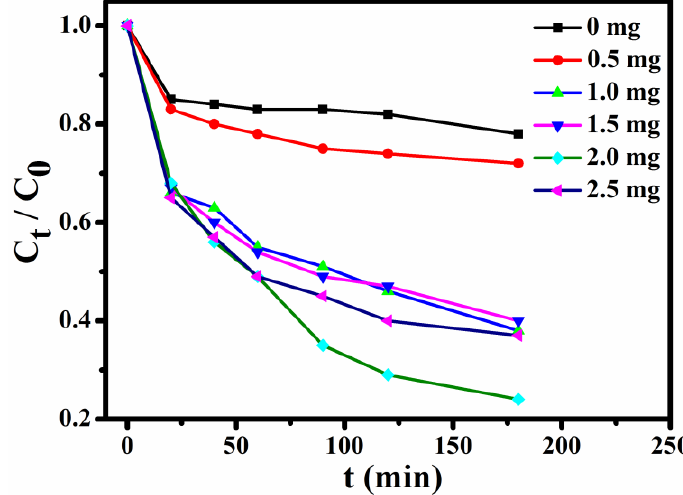
Figure 8. Effects of adsorbents usage on adsorption of MB.